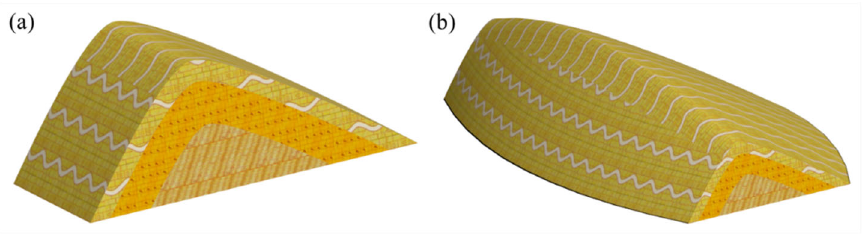
Figure 19. Examples of fold symbol models with different hinge lengths: ( a ) local morphology and ( b ) whole morphology.